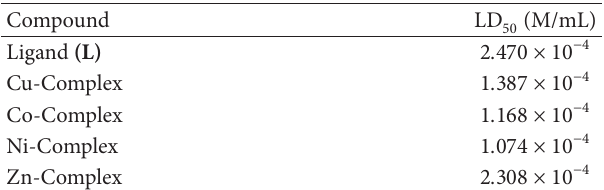
+ indicates turbidity is observed. − indicates turbidity is not observed. ∗∗∗ represents the MIC value. Table 8: Brine shrimp bioassay data of the Schiff base ligand (L) and its metal complexes.